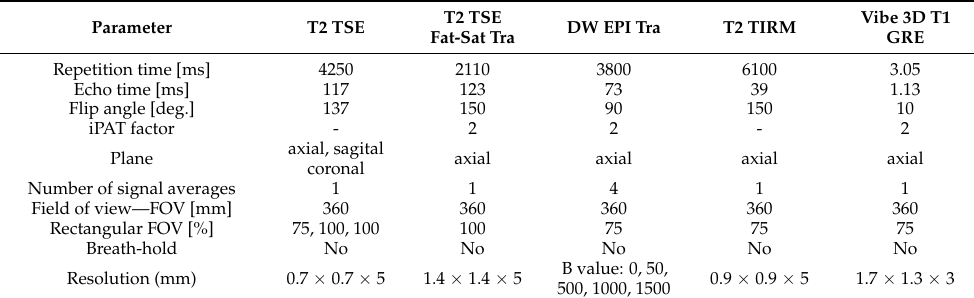
Table 2. Main parameters of applied MR sequences *. Parameter T2 TSE T2 TSE Fat-Sat Tra DW EPI Tra T2 TIRM Vibe 3D T1 GRE Repetition time [ms] 4250